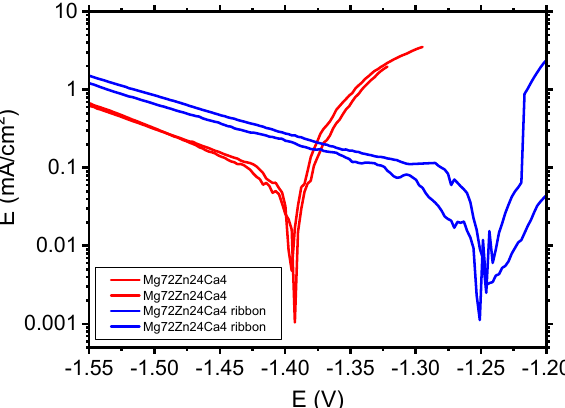
Figure 10. Polarization curves performed for Mg 72 Zn 24 Ca 4 bulk material samples and Mg 72 Zn 24 Ca 4 ribbons in Ringer’s solution at 37 ° C, pH 7.2.